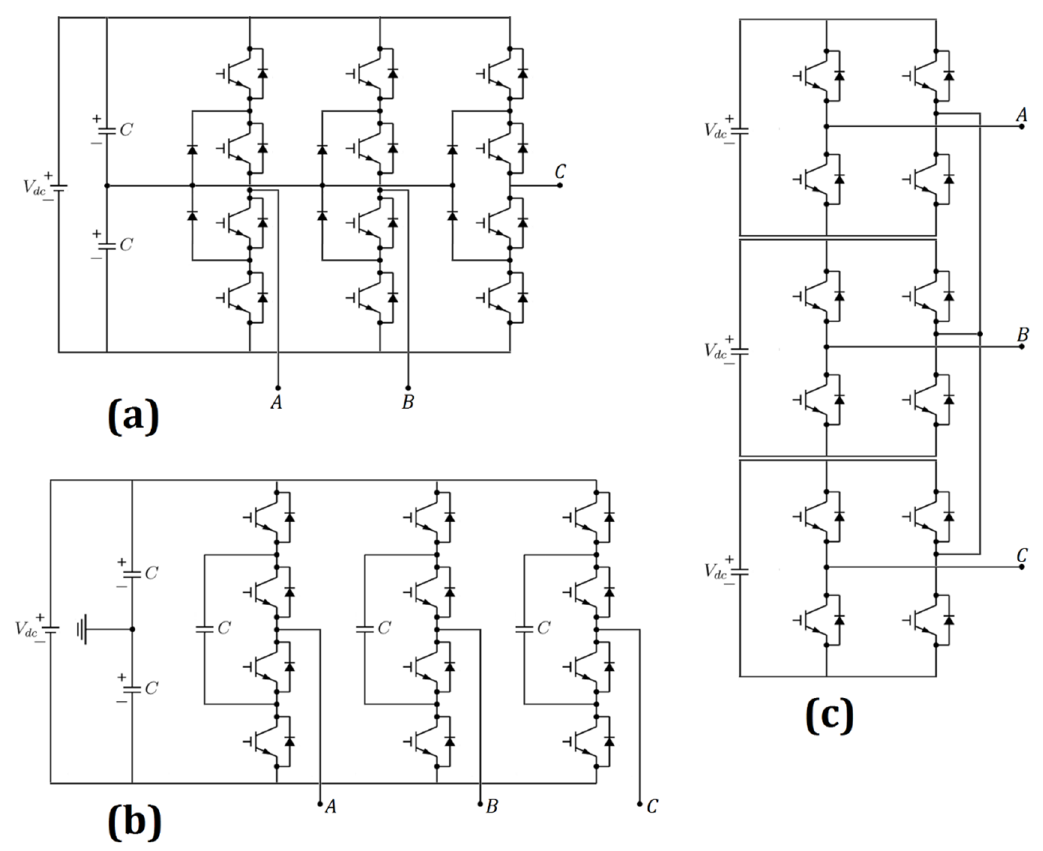
Figure 1. Circuit diagrams of three-level/phase: ( a ) neutral point clamped (NPC); ( b ) flying capacitor (FC); and ( c ) cascade H-bridge (CHB).